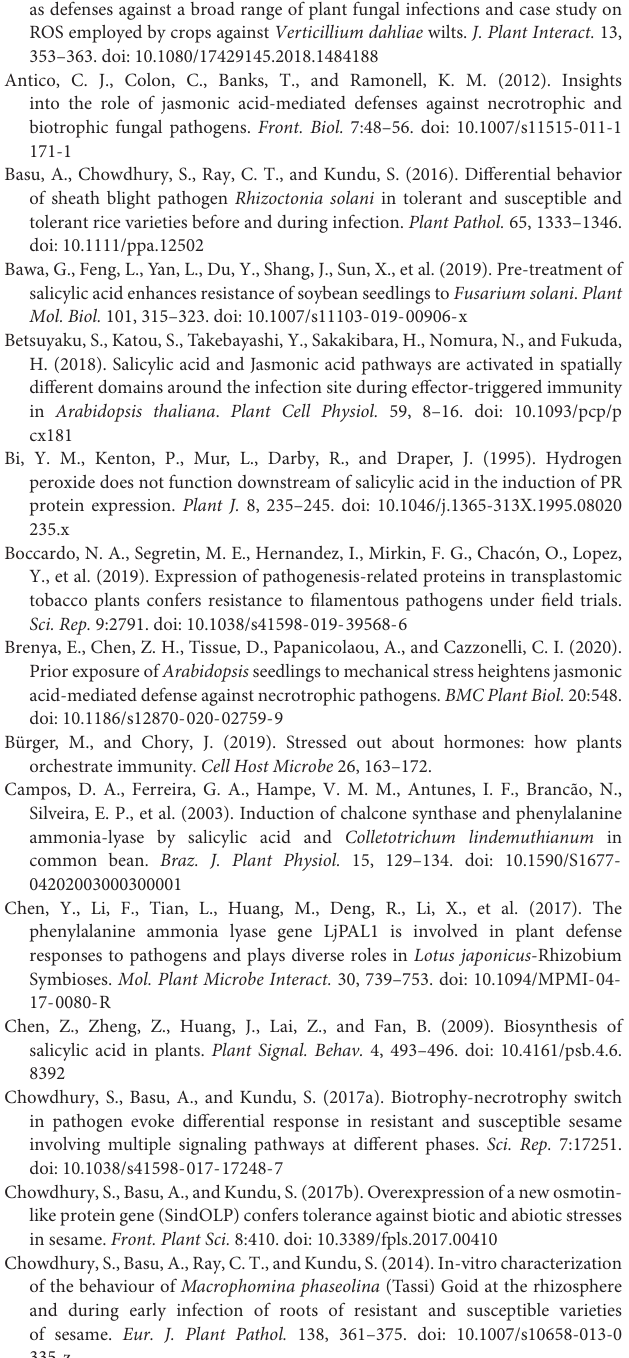
Supplementary Figure 6 | Culture of Rhizoctonia solani on PDA media supplemented with SA in increasing concentrations to assay the effect of SA on the growth of the fungus. Bar = 2 cm.